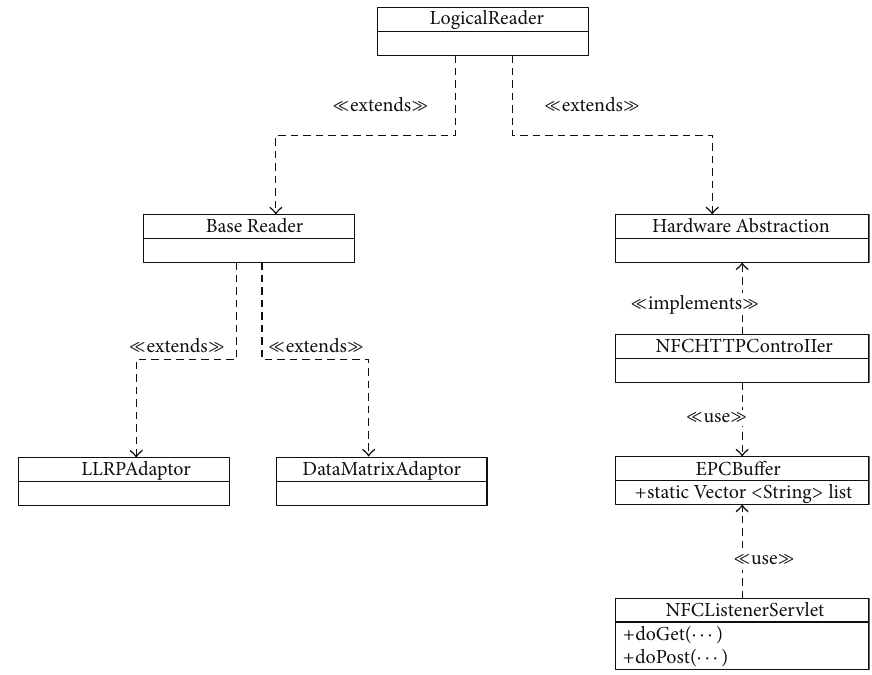
Figure 7: The integration of different physical sensing technologies in Fosstrak.